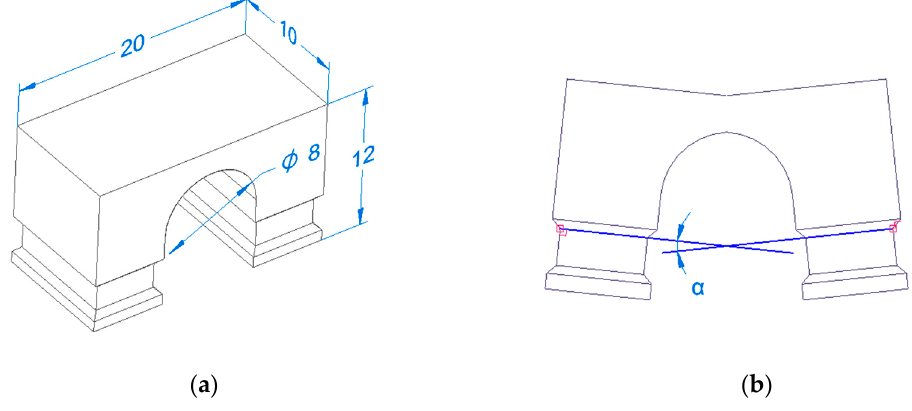
Figure 2. Improved shape of bridge curvature method (BCM) method ( a ); measurement methodology of curling angle α ( b ).